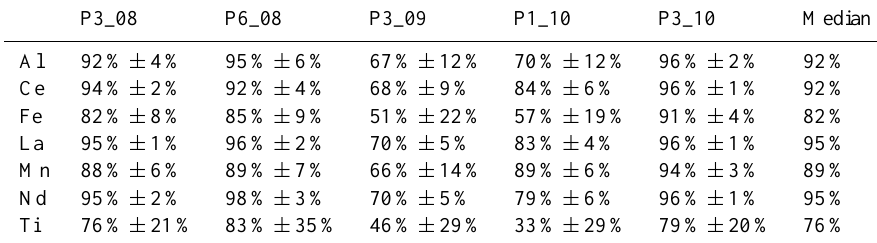
Table 4a. Solubility (%) in rainwater for the five non-contaminated samples.